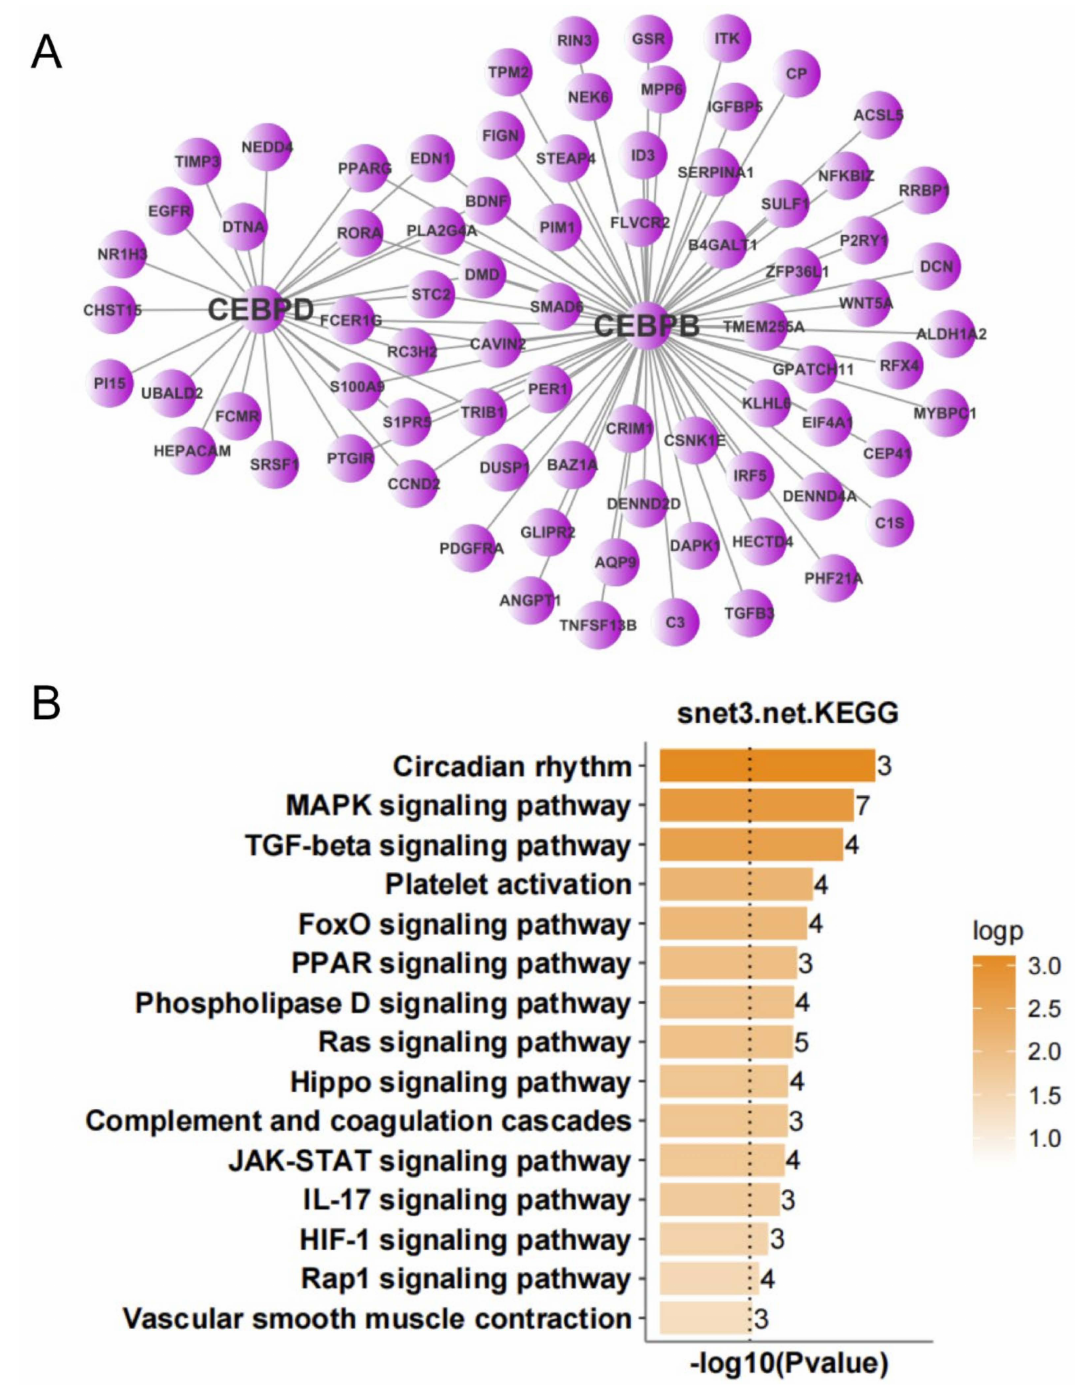
Figure 7. Expression regulation network and Kyoto Encyclopedia of Genes and Genomes (KEGG) analysis of up-regulated genes in nerve tissue of amyotrophic lateral sclerosis (ALS) patients. ( A ) Sub- network with CEBPB and CEBPD as the main regulatory factors. ( B ) KEGG analysis of subnetwork target genes with CEBPB and CEBPD as the main regulatory